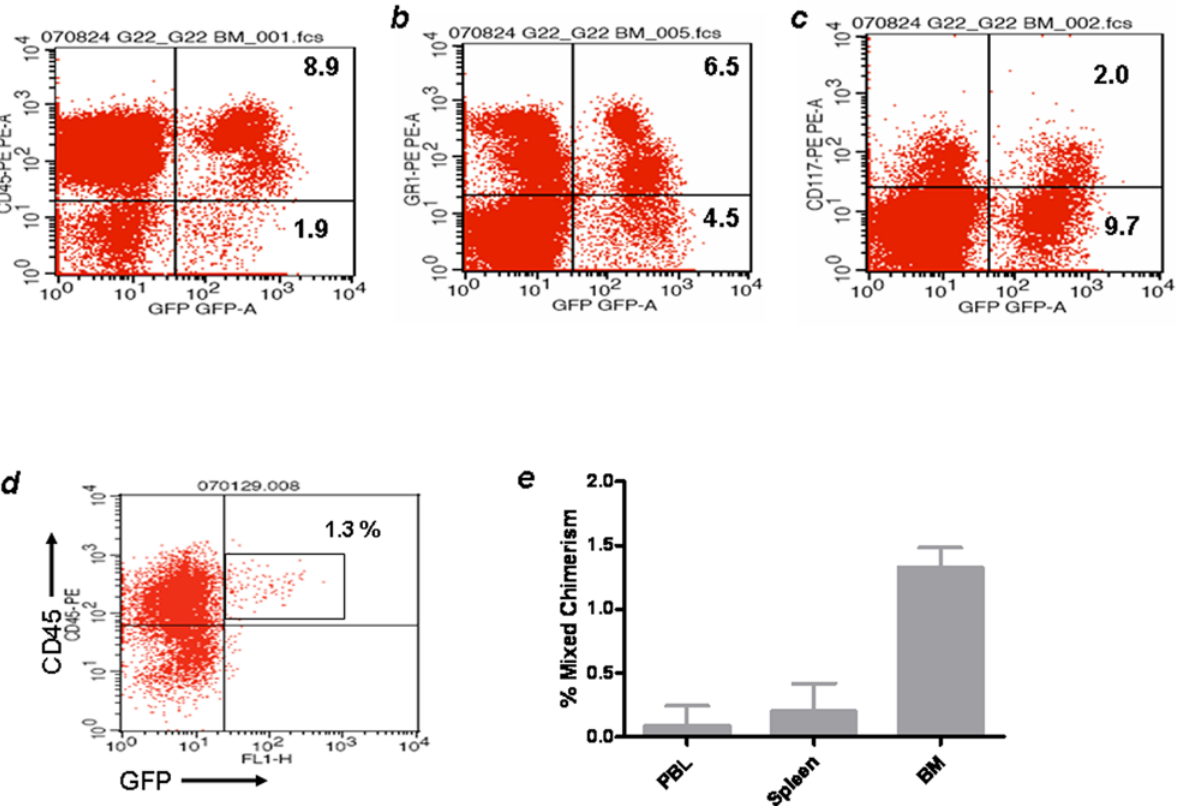
Figure 5. Tolerant mice maintain bone marrow mixed chimerism post-transplantation. The percentage of donor-derived hematopoietic cells in bone marrow cells of recipient tolerant mice was monitored using flow cytometry. A robust CD45 + cell population was detected (A) of which a large portion was Gr-1 + (B). Interestingly a small proportion of these cells was CD117-expressing, suggesting the presence of a truly bone marrow- resident stem cell population (C) . At day 100 post-transplantation, the percentage of donor cells had decreased (D) . Altogether, at day 100 post- transplantation, donor cells were hardly detectable in peripheral blood, 0.5–1% in the spleen, and 1–2% in the bone marrow ( E , n=6).